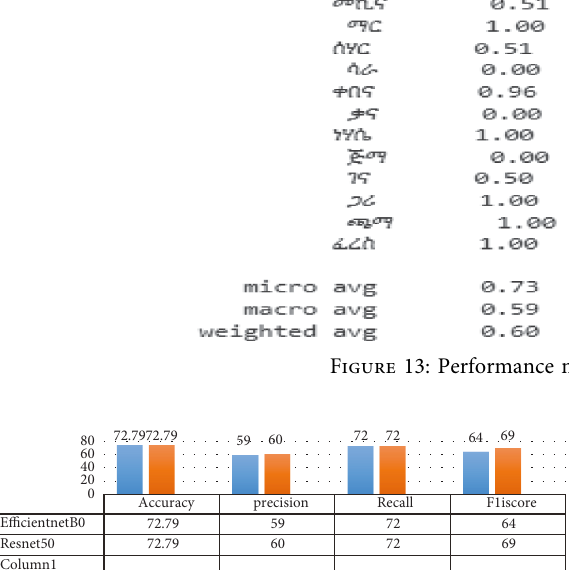
Figure 14: Model comparison by four different performance metrics.